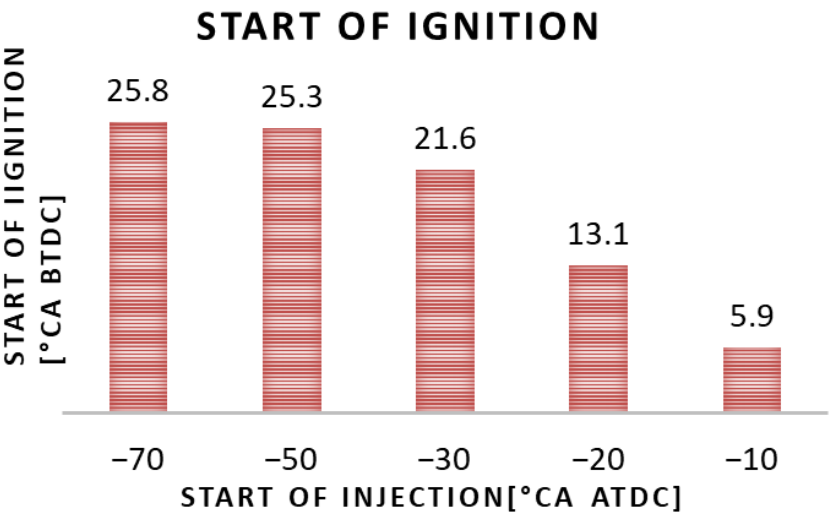
Figure 10. Effect of SOI timing on SOIgn in °CA BTDC.